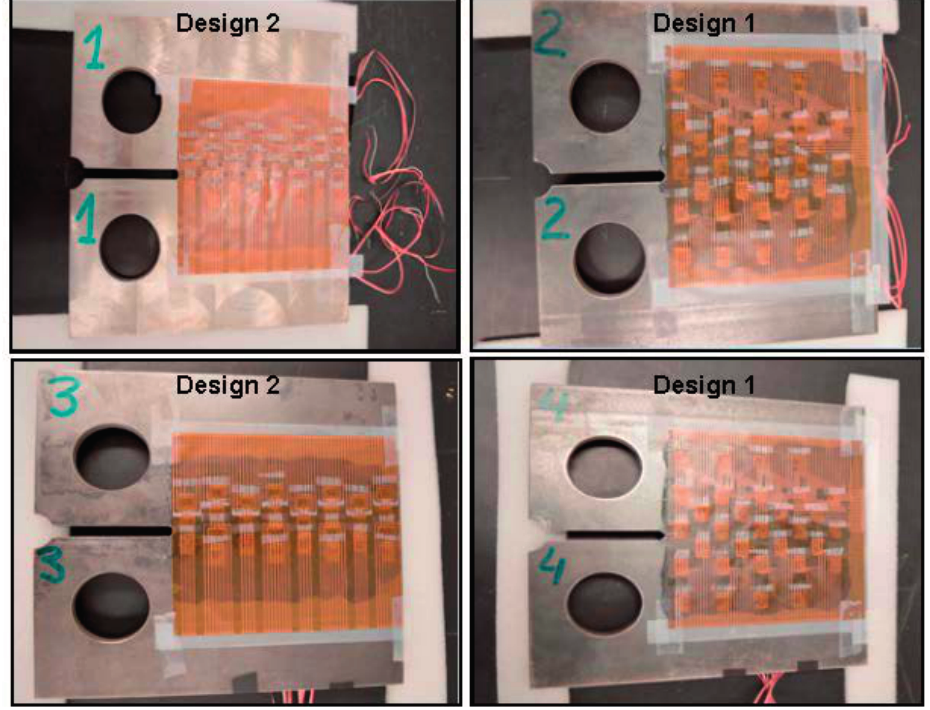
Figure 10. Four sensing sheet glued to the steel plates, and specimen labels are marked on the plates: Plates #2 and #4 are of Design 1, and Plates #1 and #3 of Design